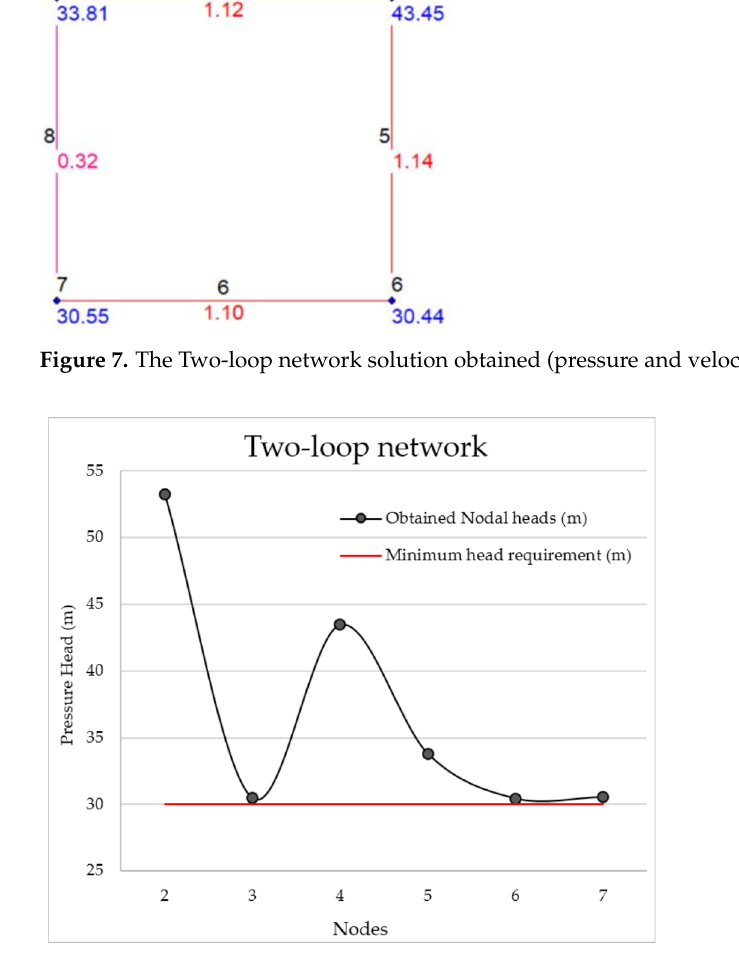
Figure 8. The Two-loop network nodal pressure heads. Table 6. Comparison of SOP–WDN results to past studies for the Two-loop